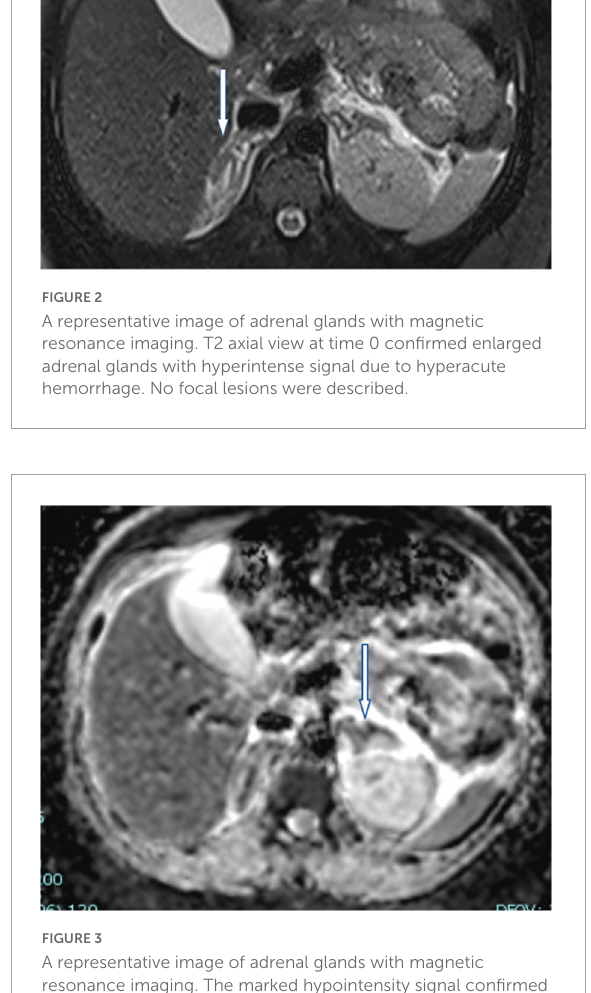
After 3 days, the patient returned to the obstetric unit, and cortisone acetate was administered at a dose of 25